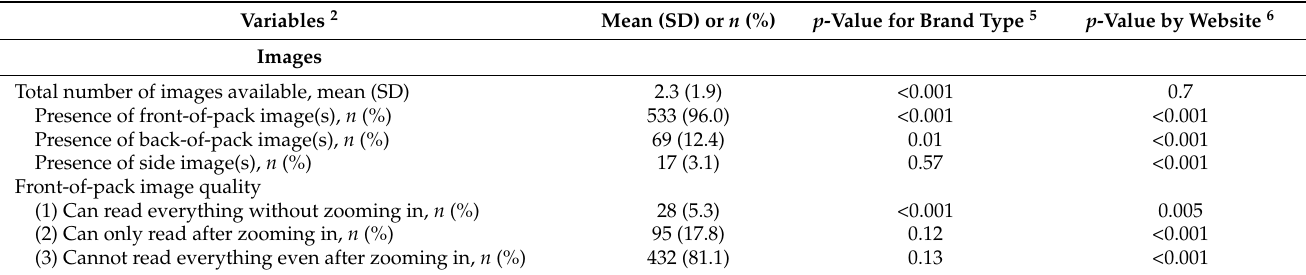
Table 2. Summary of the Availability and Quality of Labelling Information 1